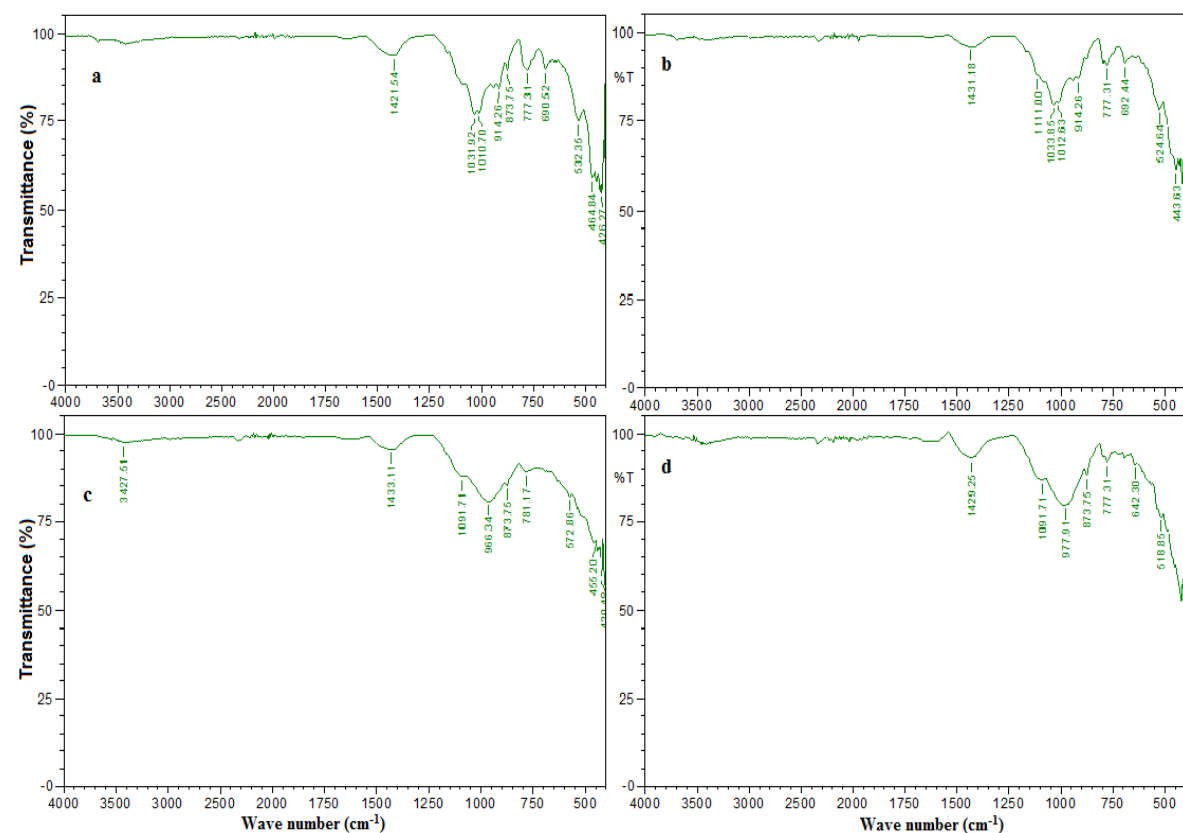
Figure 21. FTIR graph of ( a ) Fine silica sand concrete, ( b ) Coarse silica sand concrete, ( c ) River sand concrete, and ( d ) M sand concrete. Buildings 2022 , 12 , x FOR PEER REVIEW